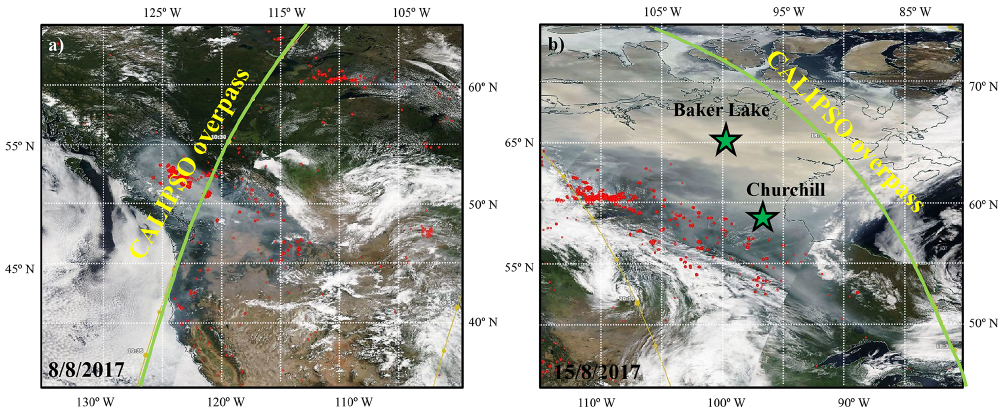
Figure 4. Corrected surface reflectance from MODIS, superimposed with active fire regions and thermal anomalies (red dots) and CALIPSO ascending and descending overpasses (green lines). Red circles denote the position of the smoke plume on (a) 8 August 2017 and (b) 15 Au- gust 2017. Green stars denote stations located underneath the smoke plume that perform regular radiosonde measurements. Maps are gener- ated from NASA Worldview Snapshots.